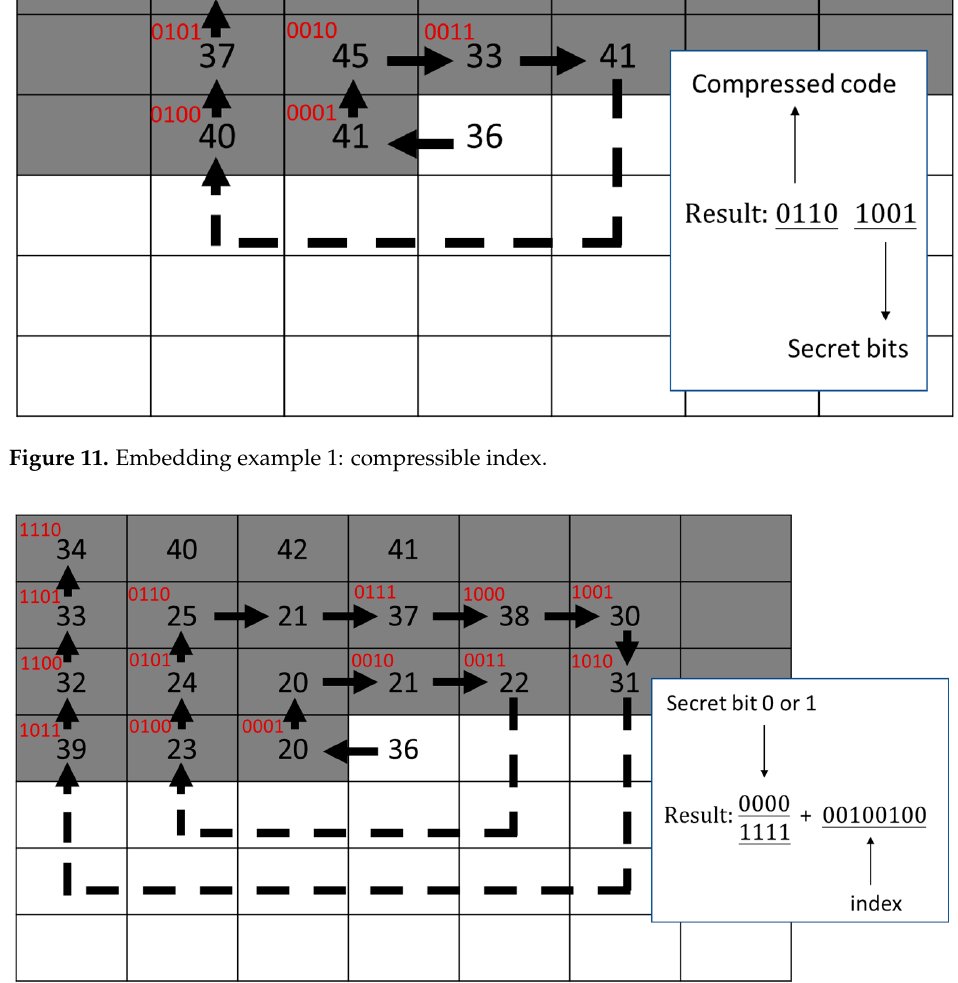
Figure 13. The second layer of data embedding.